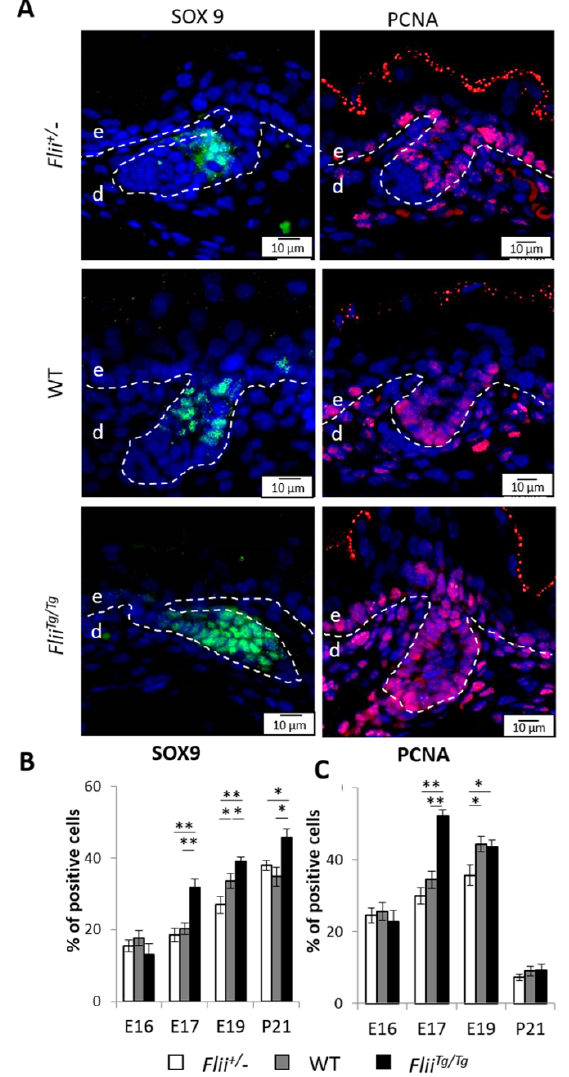
Figure 5. Overexpression of Flii gene results in increased number of SOX9 + cells and cell proliferation in basal epidermis during late embryonic development. ( A ) Immunofluorescence detection of SOX9 and PCNA positive cells in developing epidermis at E17. SOX9 + positive cells are shown as pseudo-stained green and PCNA + positive cells are shown as pseudo-stained red. Nuclear DAPI staining shown as pseudo-stained blue. The epidermal-dermal junction is shown by white dash lines; e, epidermis; d, dermis. Scale bars, 10 μ m. Flii +/ − , Flii knockdown; WT, wild-type; Flii Tg / Tg , Flii overexpressing. Quantification of ( B ) SOX9 expression as % of SOX9 + cells and ( C ) PCNA expression quantified as % of PCNA + cells in total basal cells at E16, E17, E19 and P21. N = 6. Mean ± SEM. * p < 0.05. ** p < 0.005.